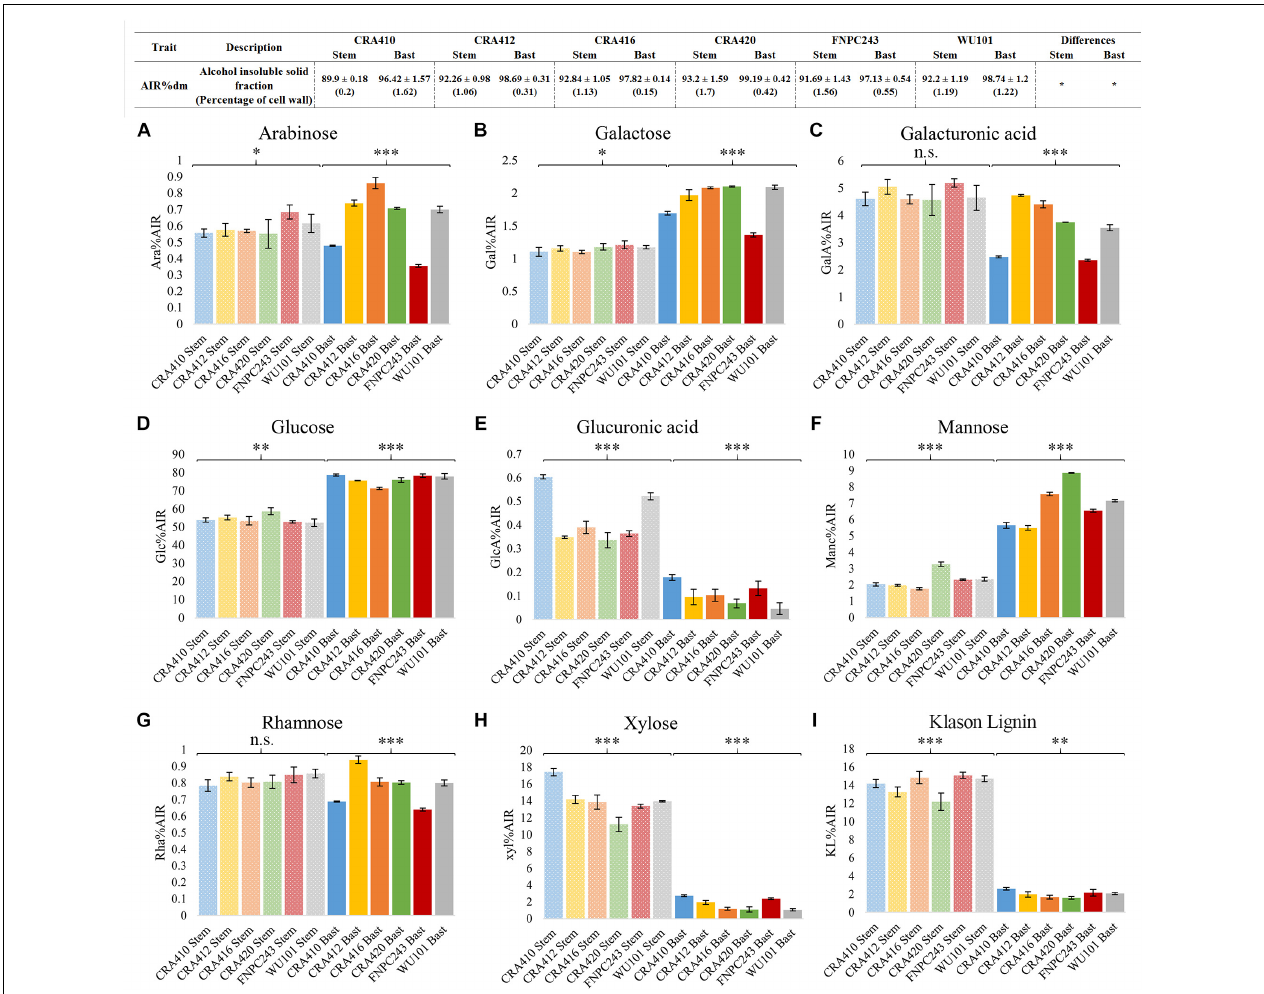
FIGURE 3 | Cell wall composition of the bast fiber and the entire stem of six hemp contrasting accessions. Table: The values correspond to the mean ± standard deviation. Percentages of coefficient of variation (CV%) between technical replicates are shown between brackets. Figure: The columns represent the means and the bar of each column represents the standard deviation. The contents of the nine cell wall components [arabinose (A) , galactose (B) , galacturonic acid (C) , glucose (D) , glucuronic acid (E) , mannose (F) , rhamnose (G) , xylose (H) , and Klason lignin (I) ] were significantly different ( p < 0.001) between the bast and the stem.